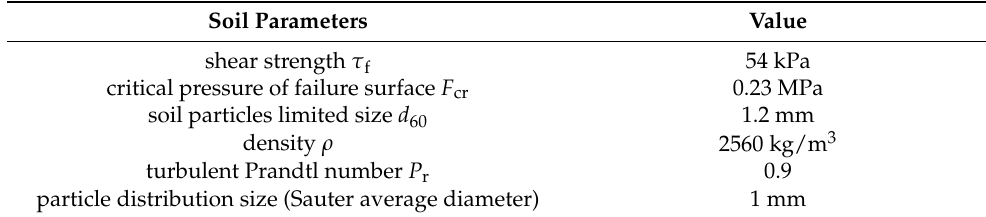
Table 1. The clayey sand powder soil